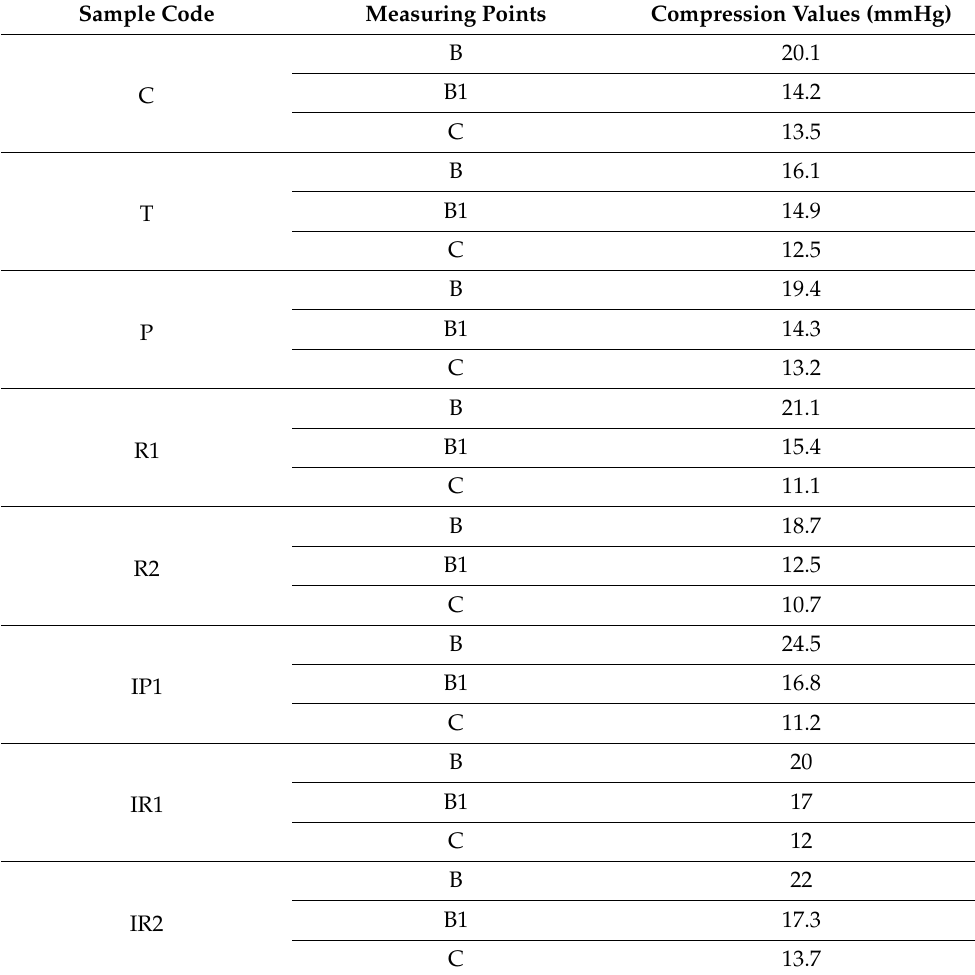
Table 6. Average pressure values.